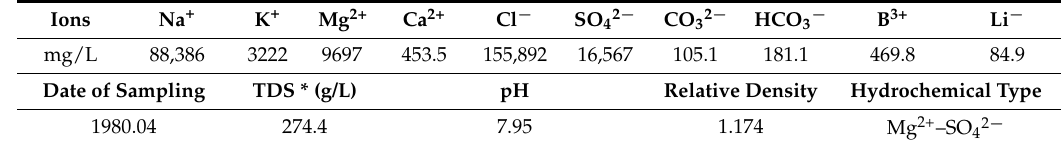
Table 2. Chemical parameters of DaQaidam saline lake brine †